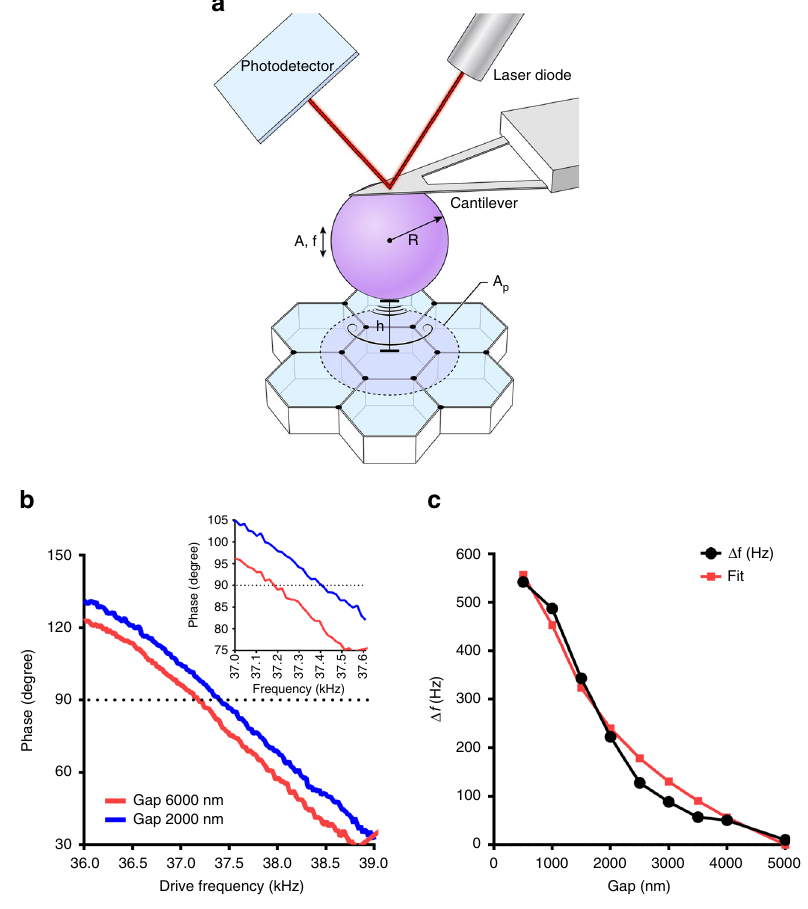
Fig. 2 Measurement of frequency shifts to determine apical epithelium mechanical properties. a Schematic diagram of the noncontact acoustic frequency modulation method to measure epithelial apical surface mechanical properties. As the acoustically vibrating cantilever with a microsphere approaches the epithelium, a hydrodynamic interaction emerges and increases monotonically as the sphere gets closer. This interaction can be measured by the AFM as an increase in frequency shift. f is the cantilever drive frequency, Δ f is the frequency shift, A is the oscillation amplitude, R is the microsphere radius, h is the distance between the microsphere and the epithelium apical surface, and A p is the effective probed area. b Phase-frequency response curves showing frequency shifts acquired by keeping π /2 phase when the acoustically vibrating microsphere is moved closer to the apical epithelium surface. Dotted line represents π /2 phase. c Representative example of frequency shift measurements performed on a MDCK II polarized monolayer at different distances. Reconstructed frequency shift-gap curves were then fi tted using Eq. (1) to determine the apical epithelial surface tension. The red line depicts the fi tted